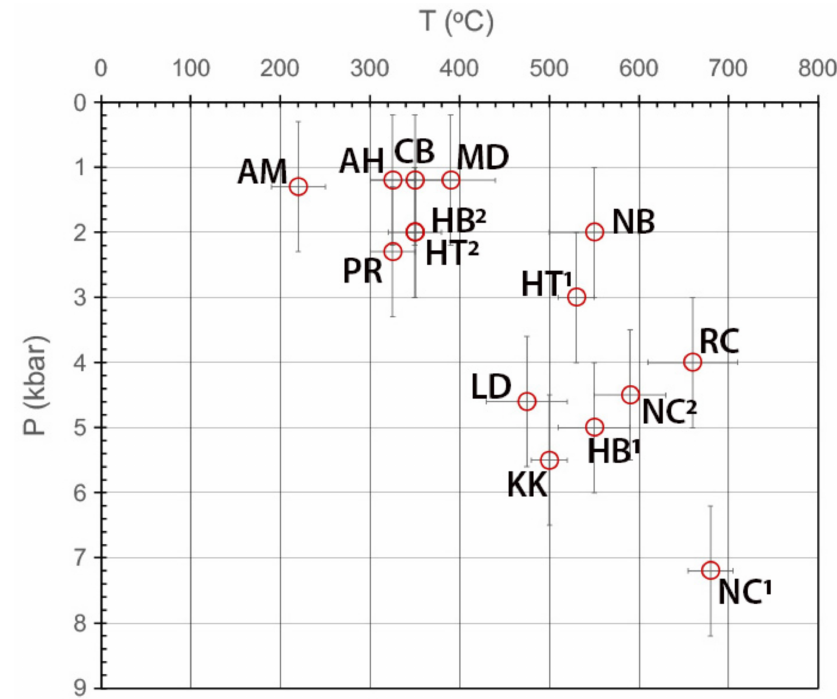
Figure 3. Pressure-temperature conditions of mineralization. Error bars indicate level of uncertainty. New Consort (NC 1 , NC 2 : 1st and 2nd stages of mineralization), Cuiab á , (CB) Ajjanahalli (AH), Renco (RC), Hutti (HT 1 , HT 2 ), Hira Buddini (HB 1 , HB 2 ), Lega Dembi (LD), Navachab (NB), Mindyak (MD), Kochkar (KK), Awak Mas